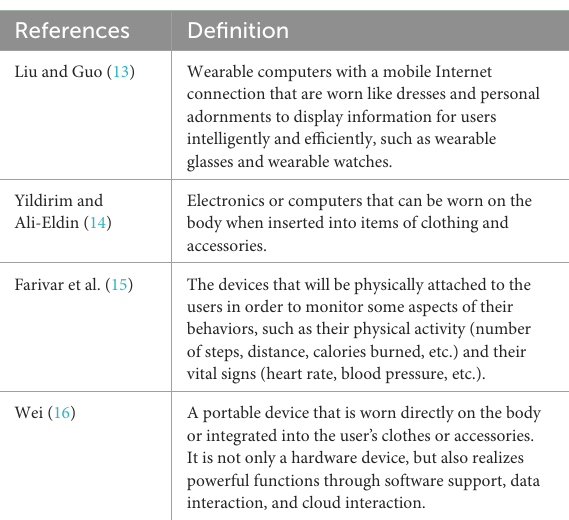
TABLE 1 Research on the definition of wearable